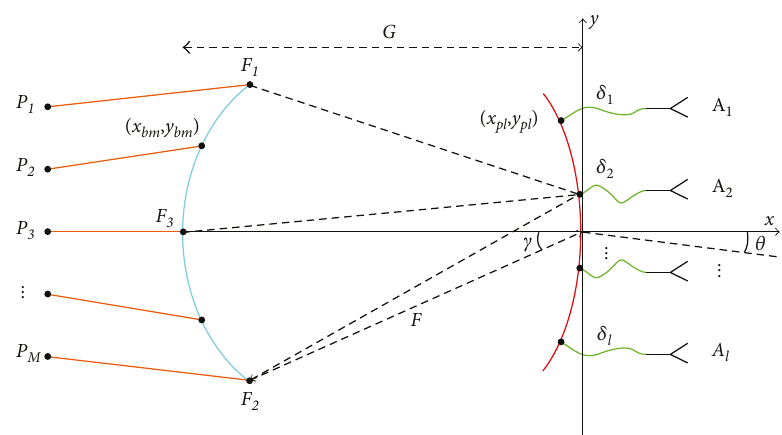
Figure 1: Geometry of the Rotman